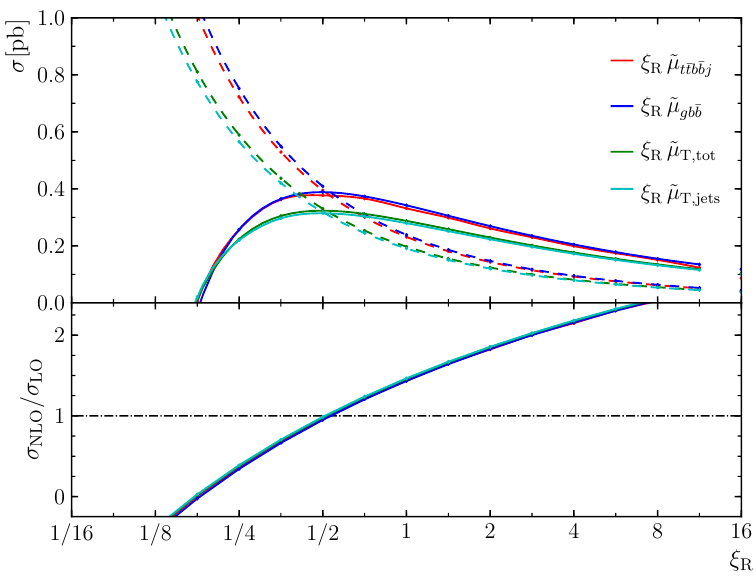
Figure 6. Renormalisation-scale dependence of the t (cid:22) tb (cid:22) bj cross section at p s = 13 TeV. Same predictions and variations as in (cid:12)gure 5, but with the aligned central scales de(cid:12)ned in (4.13). of (cid:27) NLO at the maxima di(cid:11)er by about 10%. Such di(cid:11)erences are most likely due to